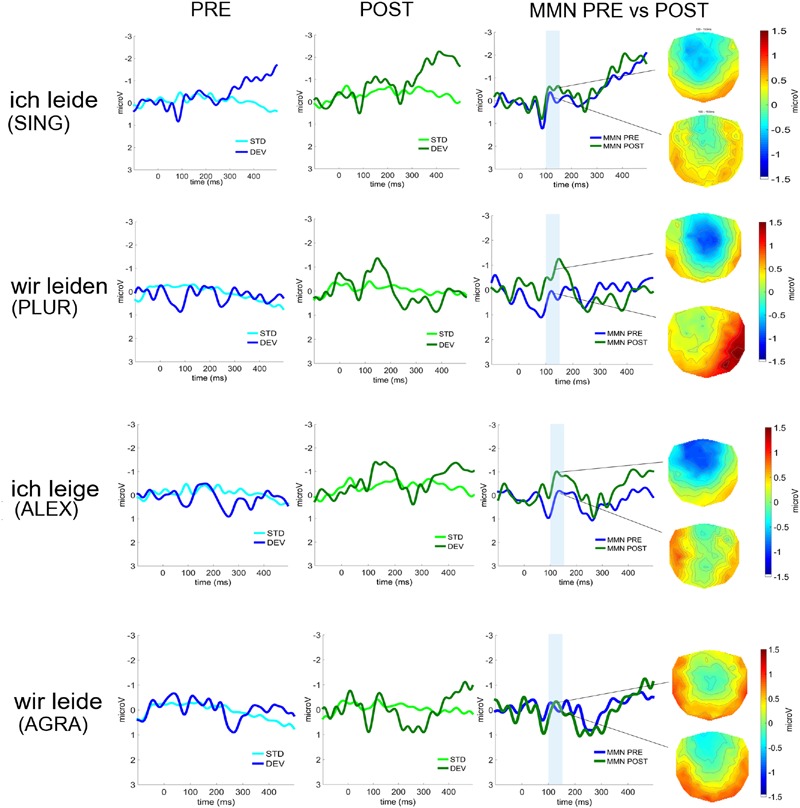
Event-related potentials (average over 22 fronto-central electrodes) to deviant and standard stimuli before (left, in blue) and after therapy (middle, in green) for the four deviant sentence types (from top to bottom: SING; PLUR; ALEX; AGRA). The MMNs before (in blue) and after (in green) therapy and their scalp distributions are shown on the right. Time window chosen for statistical analysis are highlighted in light blue.